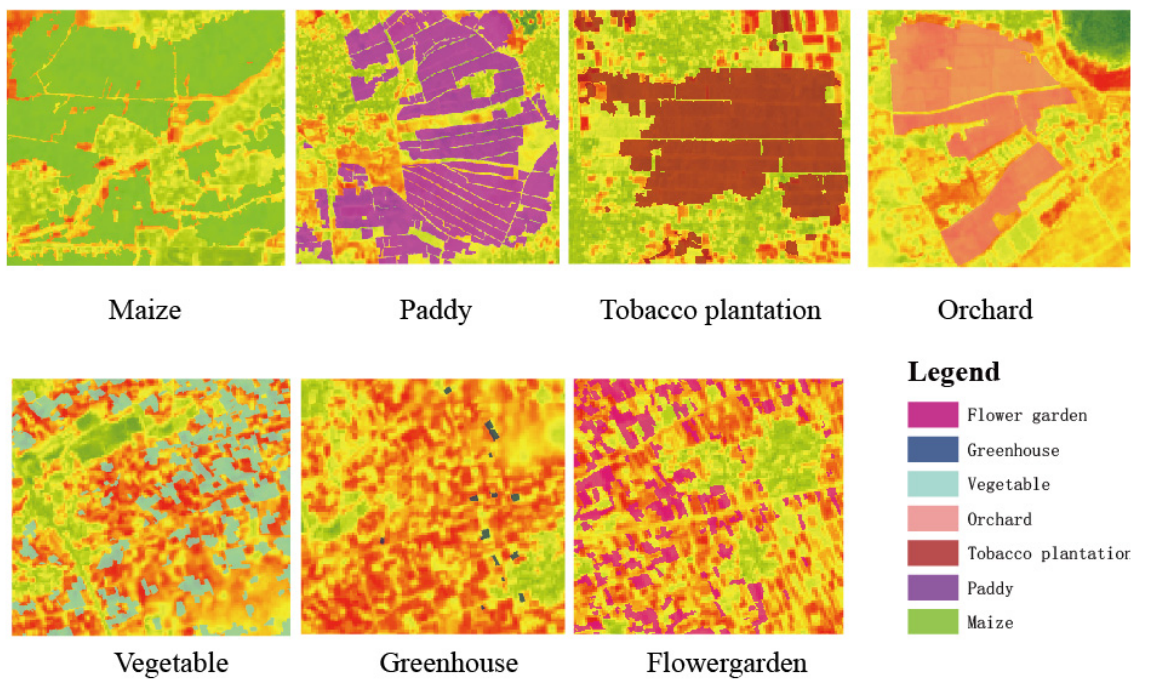
Figure 13. Characteristics of crop patches in the study area. The retrieval NDVI result of the double- attention RNN is used as the base map, and various crop types are shown in different colors.